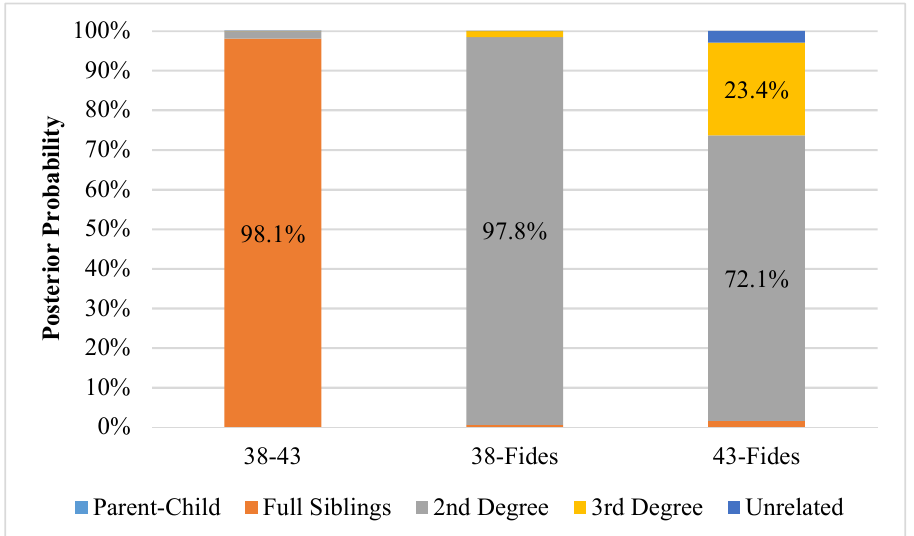
Figure 4. Posterior probability distributions of degrees of relatedness between pairwise comparisons of DNA profiles from samples 38, 43 and the buccal swab (Fides Kozulić) . Probabilities greater than 5% are labeled. Sample 40 is not shown because all pairwise comparisons produced likelihood ratios less than one for all degrees of relatedness.